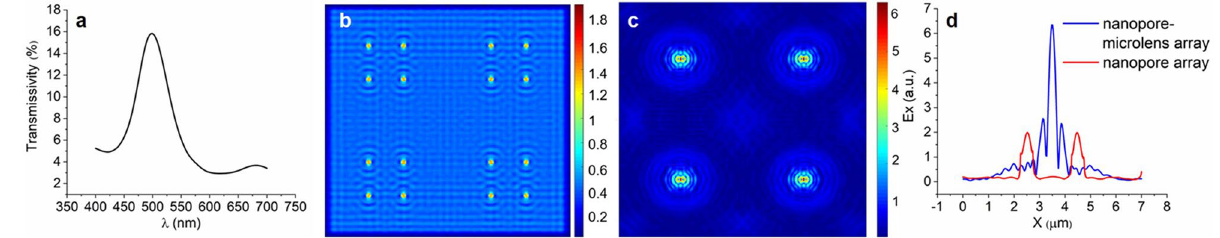
Figure 7. Transmission spectra curve ( a ); E-field distribution of nanopore array on x–y plane of z = 0 nm ( b ); E-field distribution of nanopore-microlens array on x–y plane of z = 20 nm ( c ); E-field profile of facula center ( d